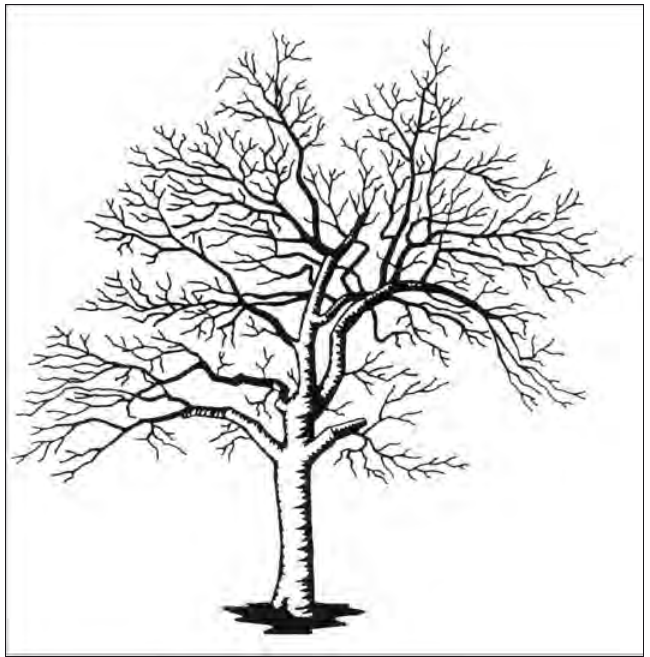
Fig. 5 - Evident epitomic behaviour in an old apple tree (from Liebster and Pesserl, 1982).